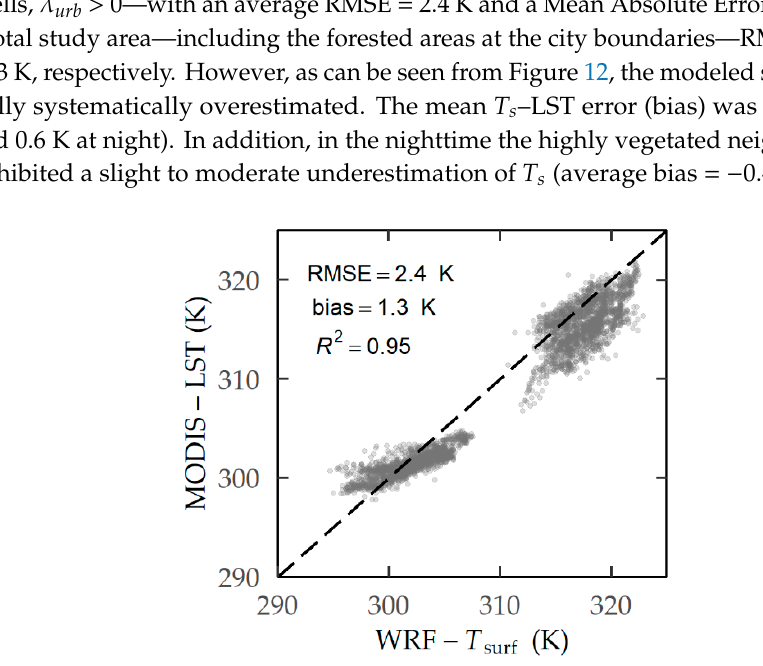
Figure 13. Spatial distribution of the modeled surface temperature in Athens using WRF ( T s ) and of MODIS–LST (Aqua) (average for the available imagery in 7–11 August 2017) during daytime ( a ) and ( c ) ( ≈ 14.30 local time), and during nighttime ( b ) and ( d ) ≈ 02.30 local time, respectively. By day (Figure 13a) LCZ 8 (high λ i and low H / W ) was correctly simulated to have a higher surface temperature of ≈ 2 Κ compared to the neighboring densely built districts (LCZ 2 1 and LCZ 2). At night, the center of the open set LCZ 8 zone corresponded to a local minimum, 0.5–1 K cooler than the central areas with closely packed buildings (Figure 13b), in agreement to Aqua observations (Figure 13d). In addition, the model-observation comparison demonstrates that WRF noticeably